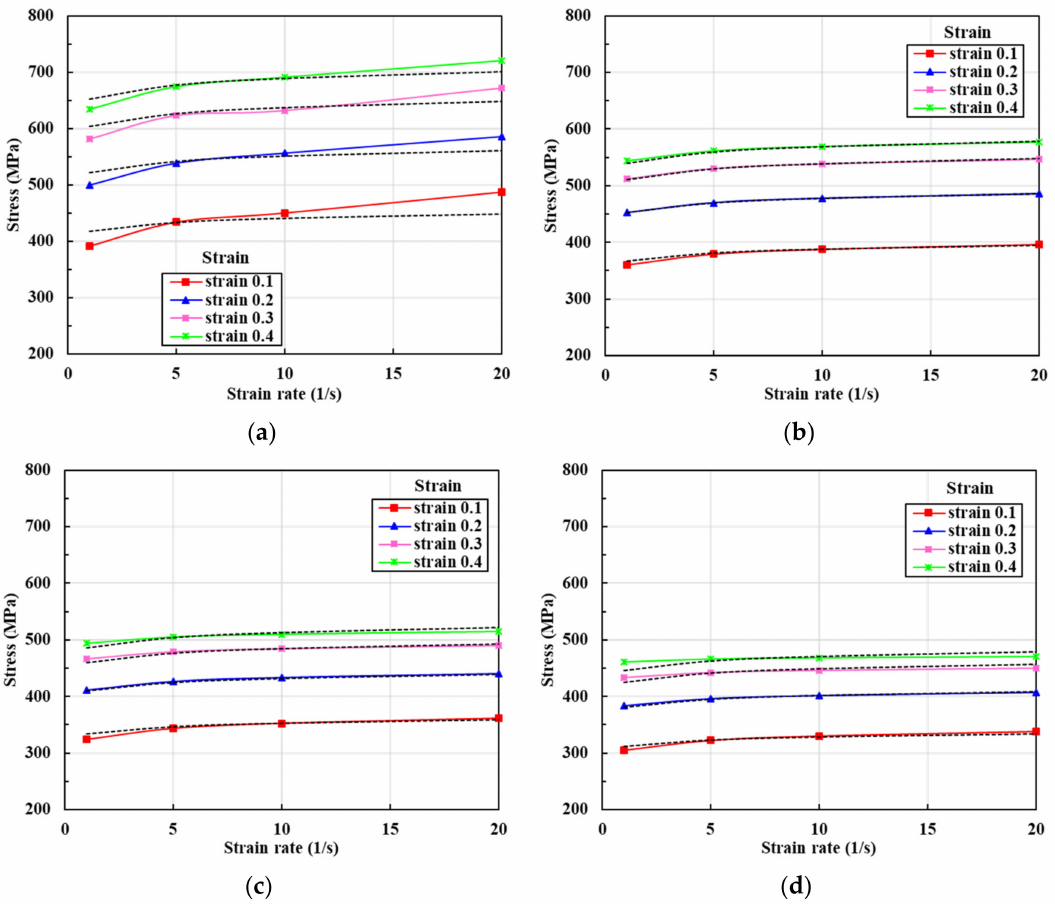
Figure 6. Changes in flow stress by strain rate at various sample strains and temperatures: ( a ) 100 ◦ C;